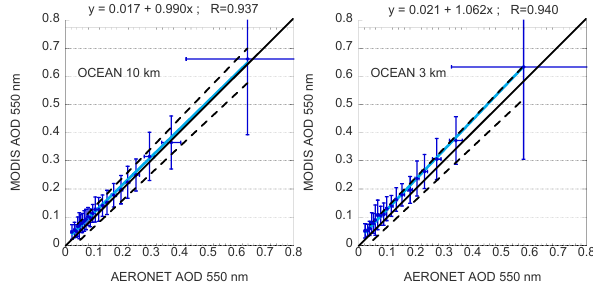
Fig. 13. Same as Fig. 12, but for over ocean retrieval. Here, the linear regression line is in light blue and the 1:1 line is in black.